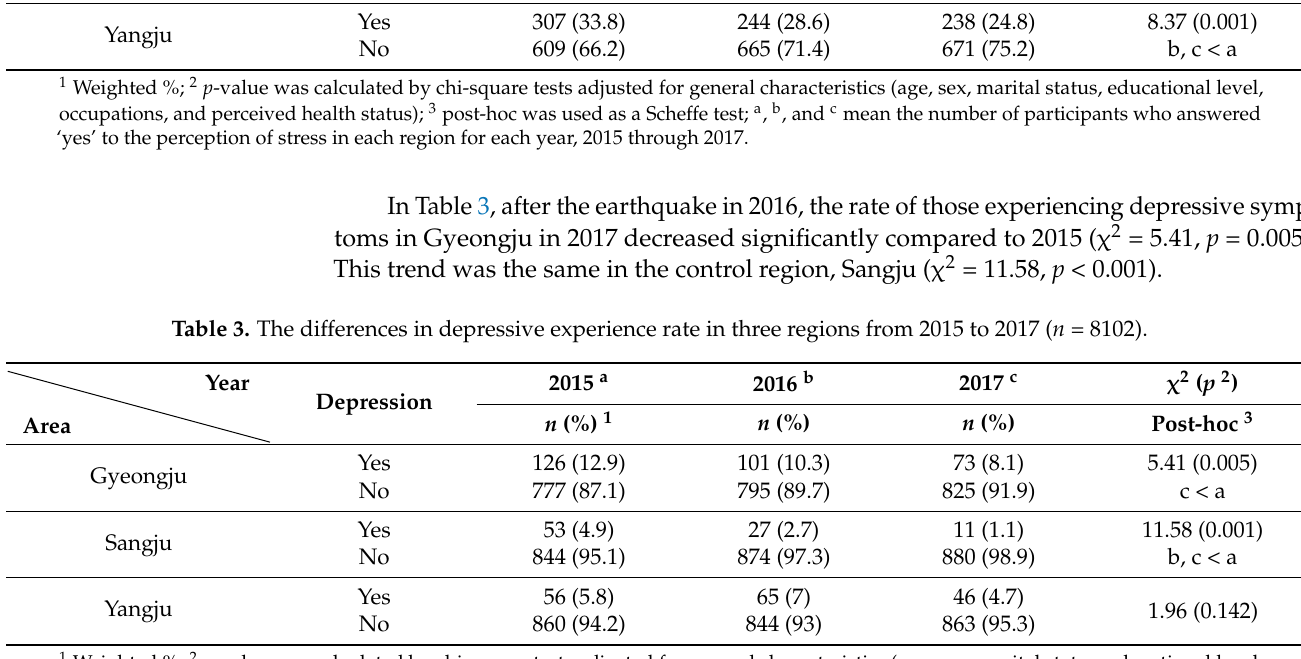
Table 2. The differences in stress perception rates in the three regions from 2015 to 2017 ( n = 8102). Year Stress Area